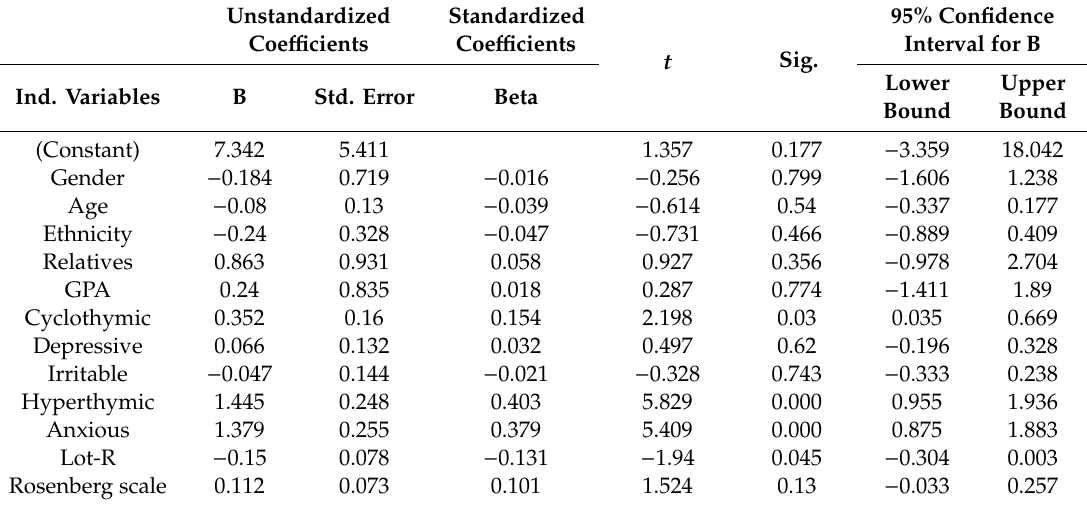
Table 3. Multipleregressionanalysis(Model2). Predictorsofperceivedstressinpodiatricmedicalstudents.